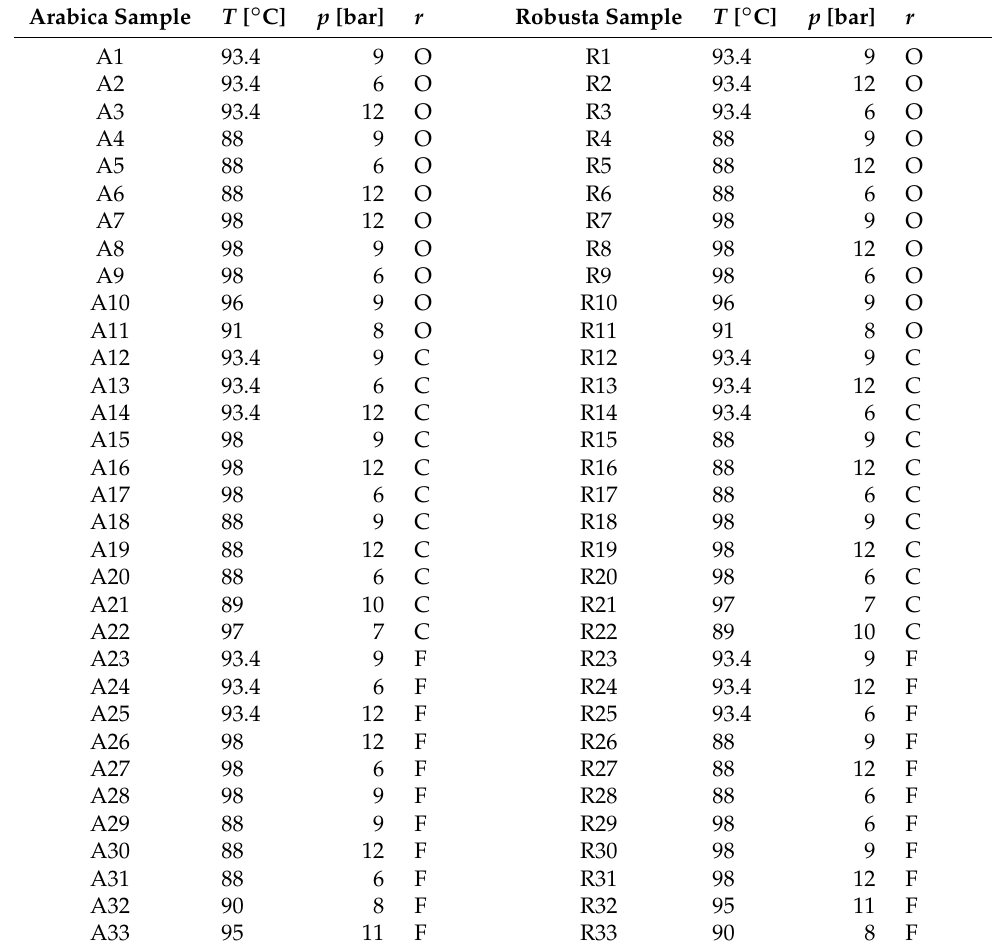
Table 1. Extraction conditions of each EC sample. r denotes the type of granulometry: optimal (O), coarse (C) and fine